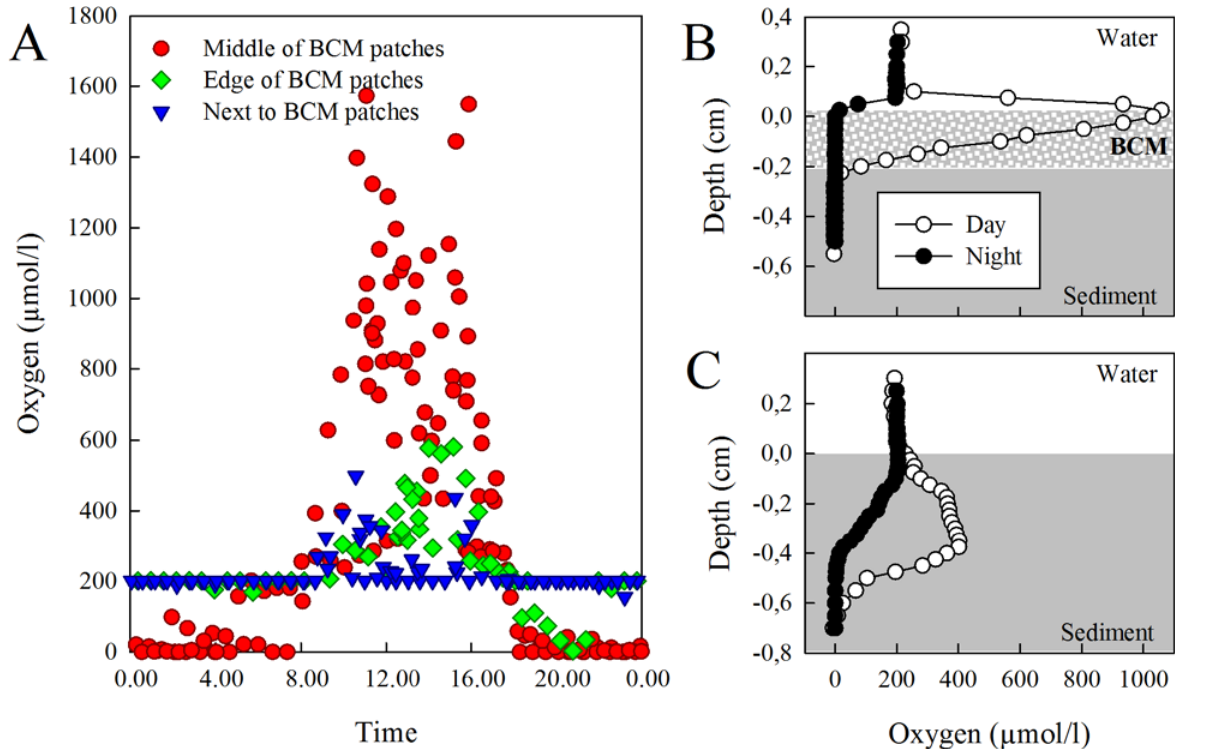
Fig 5. Oxygen concentrations in sediments across BCM patches. (A) O 2 concentration across BCM patches over an entire diel cycle. During photosynthesis, O 2 peak concentrations per profile are plotted; otherwise surface concentrations are given (n = 350 profiles). (B and C) Examples of in situ O 2 profile across the water-sediment interface during day and night with BCM (B) and without BCM